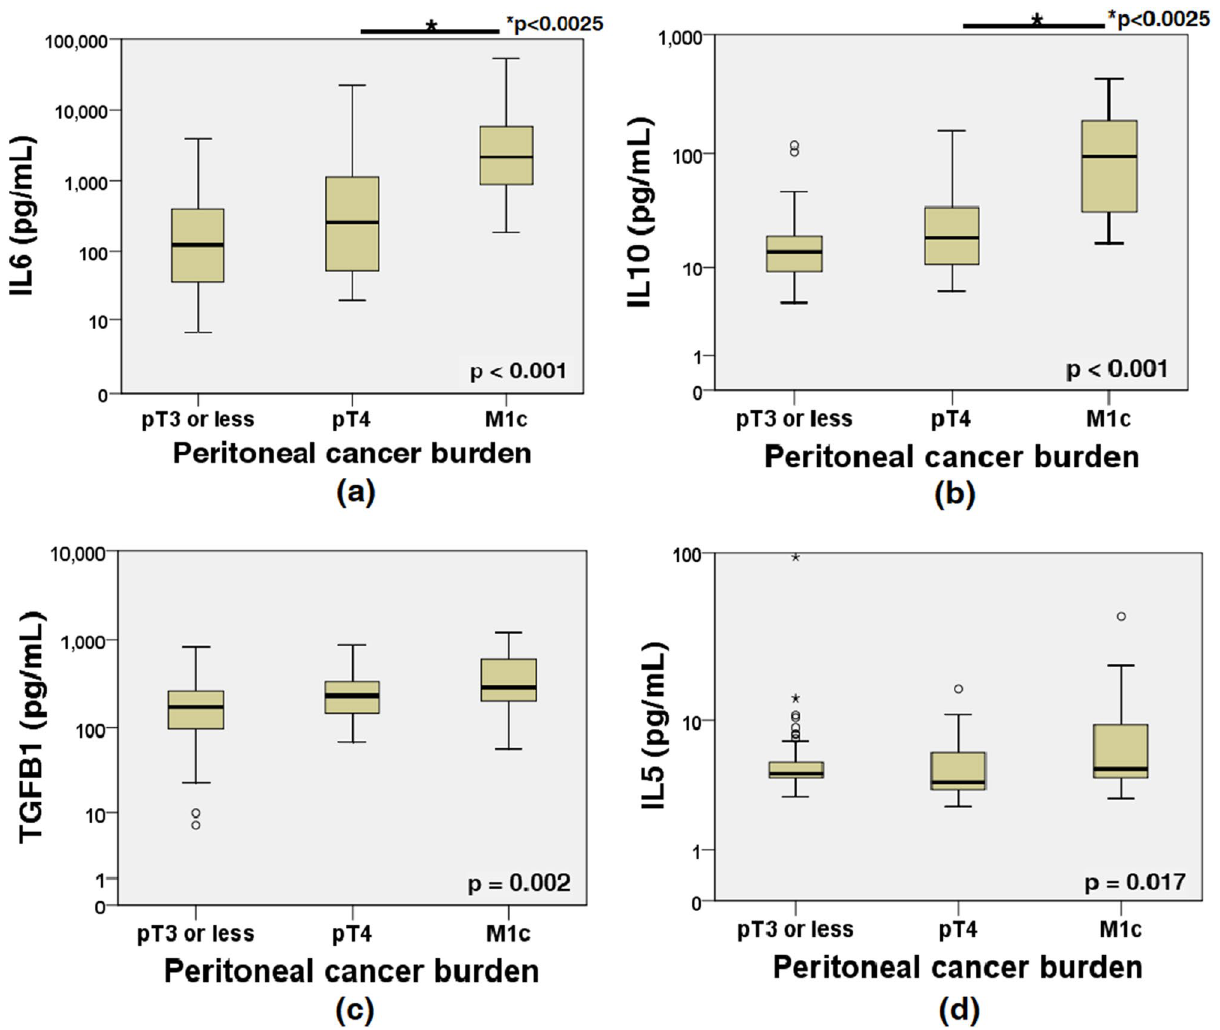
Figure 2. Cytokine concentrations in ascitic fluid according to peritoneal cancer burden. ( a ) Interleukin (IL)6 increased according to peritoneal cancer burden (p < 0.001 in K–W; p = 0.021 for ≤ pT3 vs pT4 and p < 0.001 for pT4 vs M1c in M–U). ( b ) IL10 increased according to peritoneal cancer burden (p < 0.001 in K–W; p = 0.030 for ≤ pT3 vs pT4 and p < 0.001 for pT4 vs M1c in M–U). ( c ) TGFB1 increased according to peritoneal cancer burden (p = 0.002 in K–W; p = 0.023 for ≤ pT3 vs pT4 and p = 0.153 for pT4 vs M1c in M–U). ( d ) IL5 was not significantly different according to peritoneal cancer burden (p = 0.017 in K–W; p = 0.024 for ≤ pT3 vs pT4 and p = 0.016 for pT4 vs M1c in M–U). Ordinates are plotted on a log scale. K–W Kruskal–Wallis test, M–U Mann– Whitney U